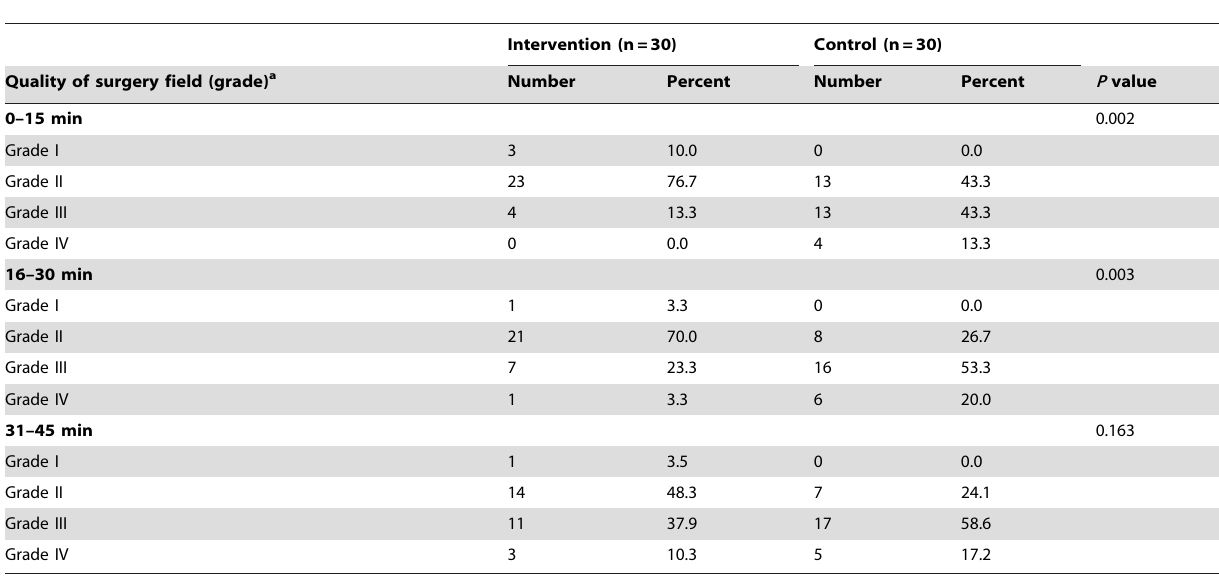
Table 3. The effect of tranexamic acid plus phenylephrine versus phenylephrine alone on the quality of surgery field by duration of time after surgery based on Boezaart grading.